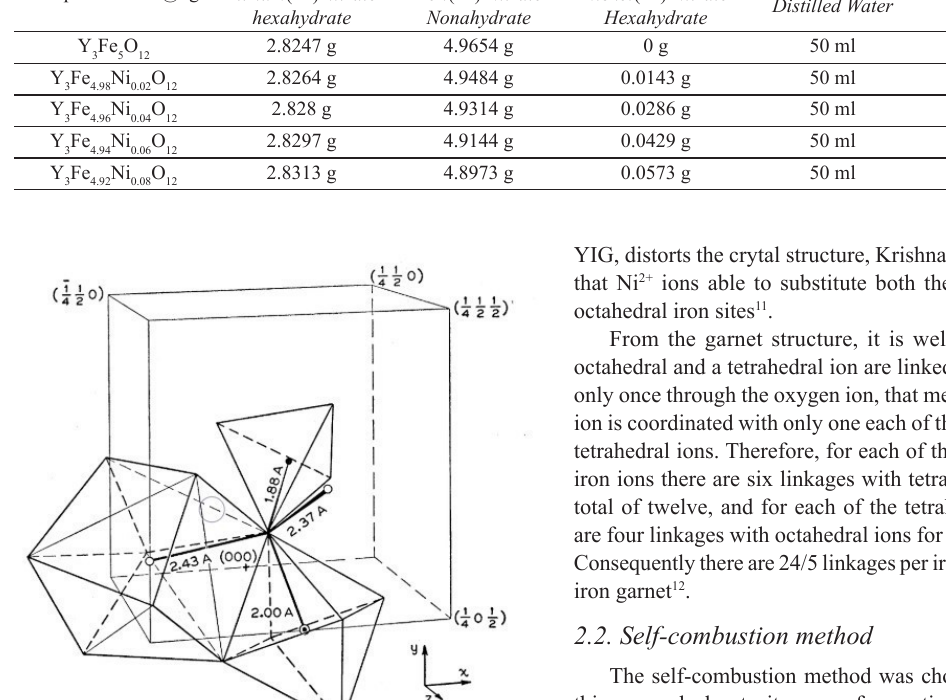
Table 1. Research Design Variations. Sample